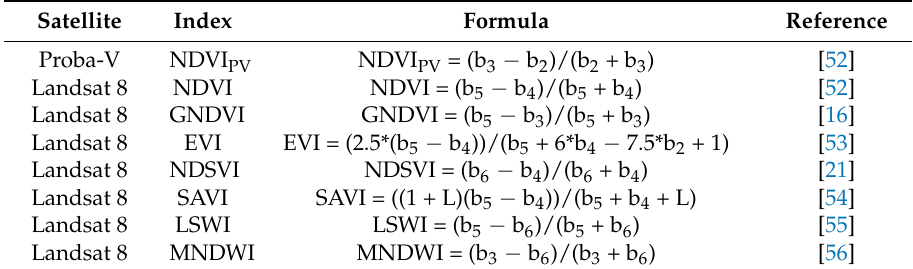
Table 2. Vegetation indices adopted for this